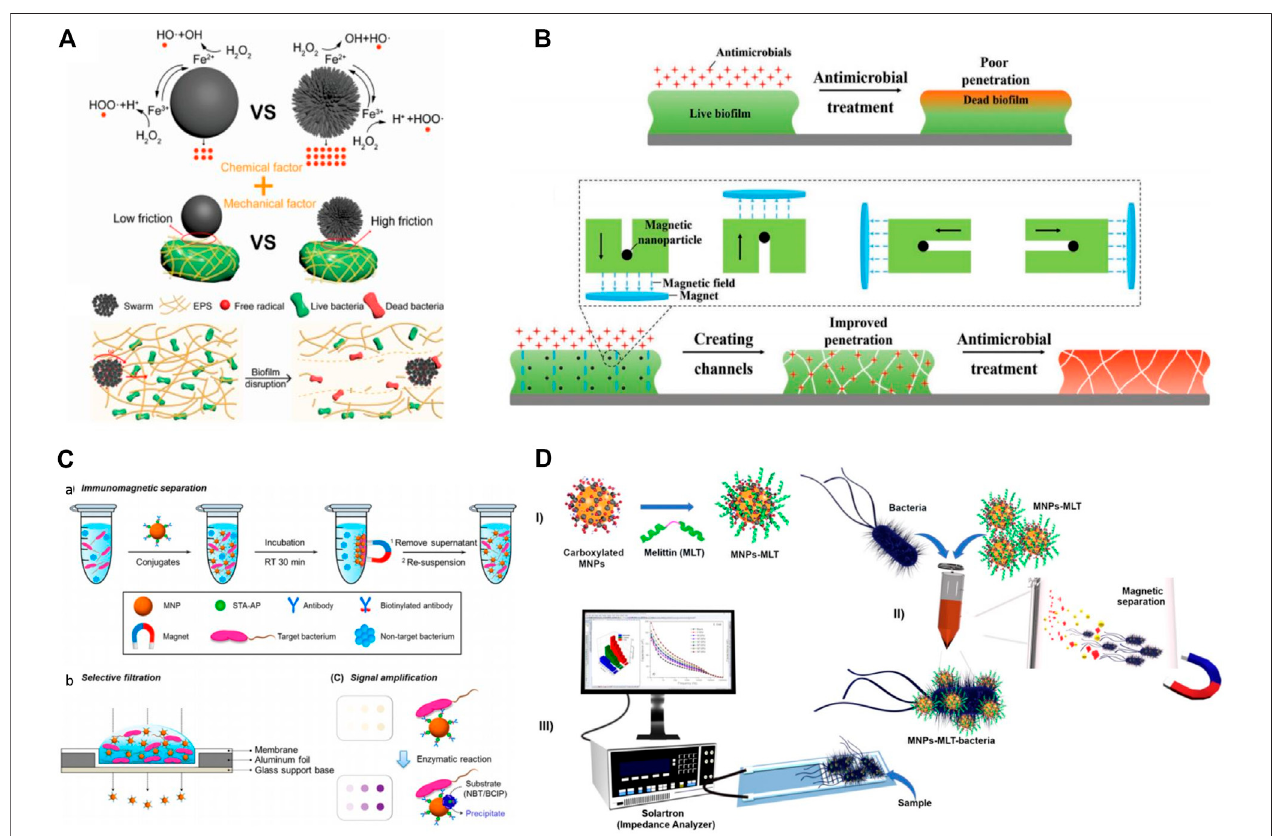
FIGURE 3 | Schematics (A) illustration of the chemical and mechanical factors of the bacteria killing of Fe 3 O 4 and p-Fe 3 O 4 MPs. and mechanism of bio fi lm disruptionbyap-Fe 3 O 4 swarm(Dongetal.,2021).Copyright2021,AmericanChemicalSociety (B) mechanisticRepresentationofarti fi cialchannelcreatedbymagnetic nanoparticles in infectious bio fi lms to improve antimicrobial penetration and enhance bacterial killing over the depth of a bio fi lm (Quan et al., 2019b). Copyright 2019, John Wiley and Sons (C) Enhanced colorimetric method using enzymatic ampli fi cation with NBT/BCIP precipitation based on IMS-selective fi ltration for the ultrasensitive detection of E. coli O157:H7: a. IMS for target bacteria using biotinylated antibody/STA − AP/MNP conjugates, b. selective fi ltration of target bacteria − conjugates complexes, and c. colored spots on the fi lter membrane by target bacteria-bound biotinylated antibody/STA − AP/MNP conjugates (upper panel) andenhancedcolorimetricspotsbyenzymaticampli fi cationwithNBT/BCIPprecipitationonthebacteria-boundbiotinylatedantibody/STA − AP/MNPconjugatesurfaces (lowerpanel)(Kimetal.,2018).Copyright2018,AmericanChemicalSociety (D) Representationoftheprincipleofthebioanalyticalmethod.FunctionalizationofMNPs(I); capture of bacteria by MNPs-MLT and magnetic separation of the bacteria from the sample matrix (II); EIS detection (III) (Wilson et al., 2019). Copyright 2019, Elsevier publishing